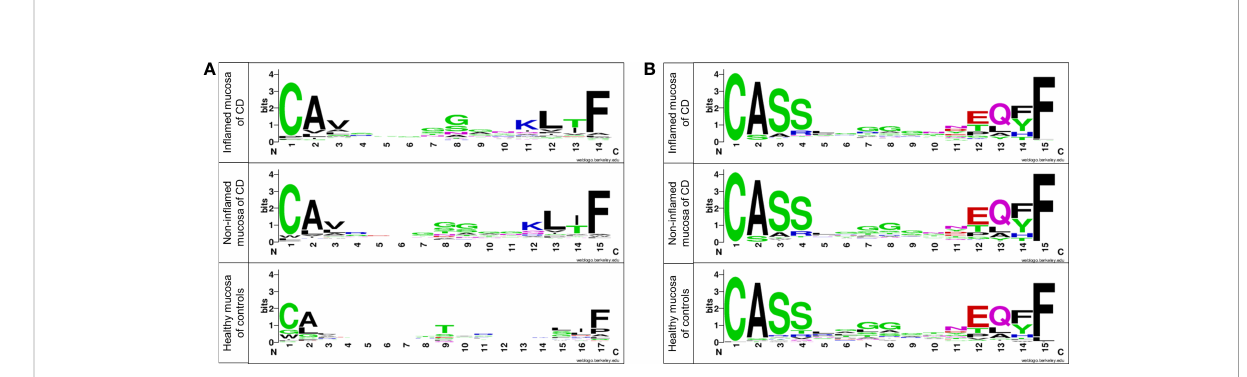
FIGURE 7 Sequence logos of amino acids in the CDR3 motif of (A) TRA and (B) TRB in patients with CD and controls. Each logo consists of stacks of symbols, one stack for each position in the sequence. The overall height of the stack indicates the sequence conservation at that position, while the height of symbols within the stack indicates the relative frequency of each amino at that position (Crooks et al.,